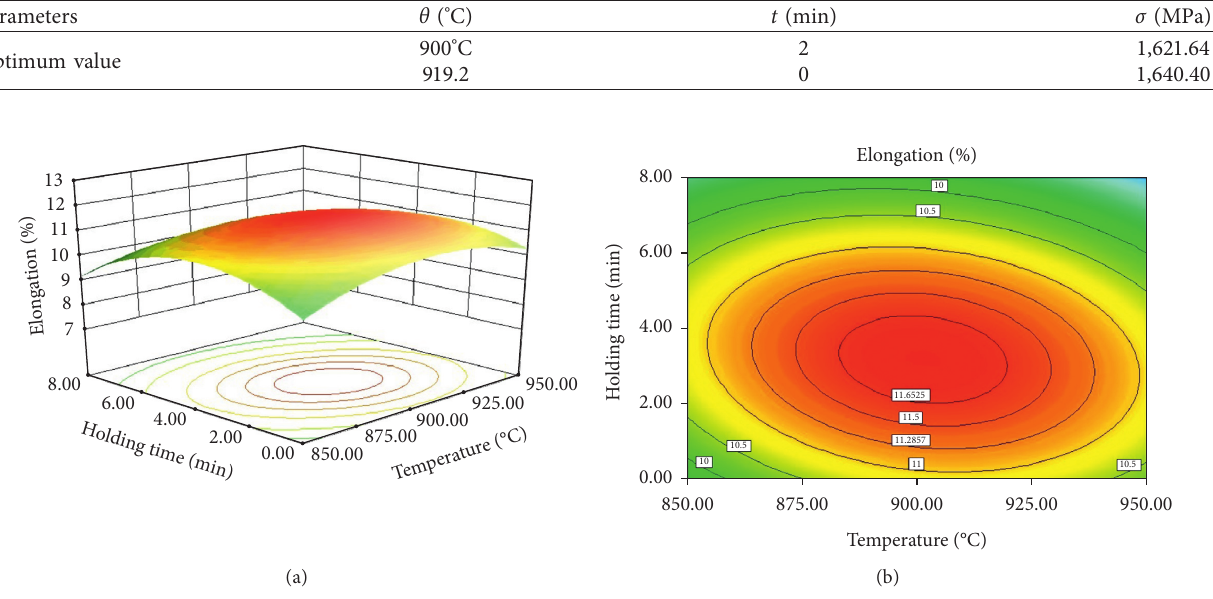
Figure 10: (a) 3D response surface for elongation and (b) 2D contour for elongation.